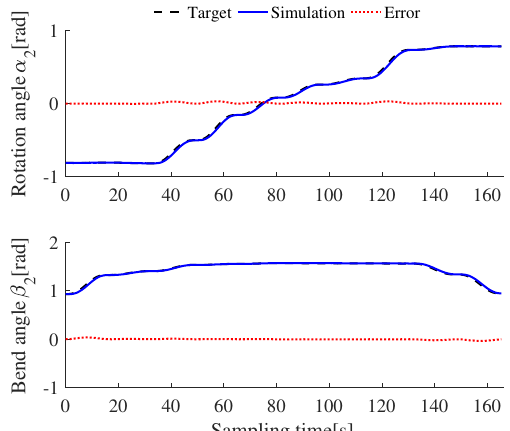
Figure 14. The comparison of the virtual joints in the continuous segment